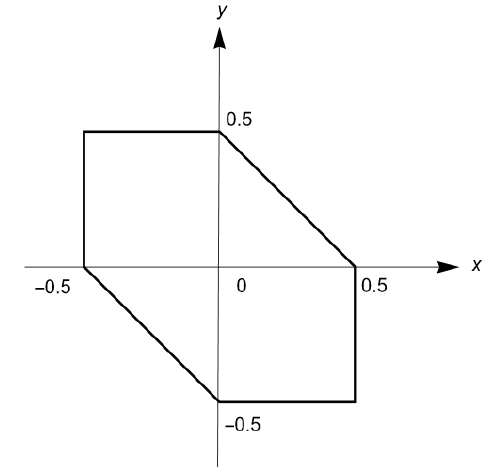
Figure 1. The graph of the circle C 0,1